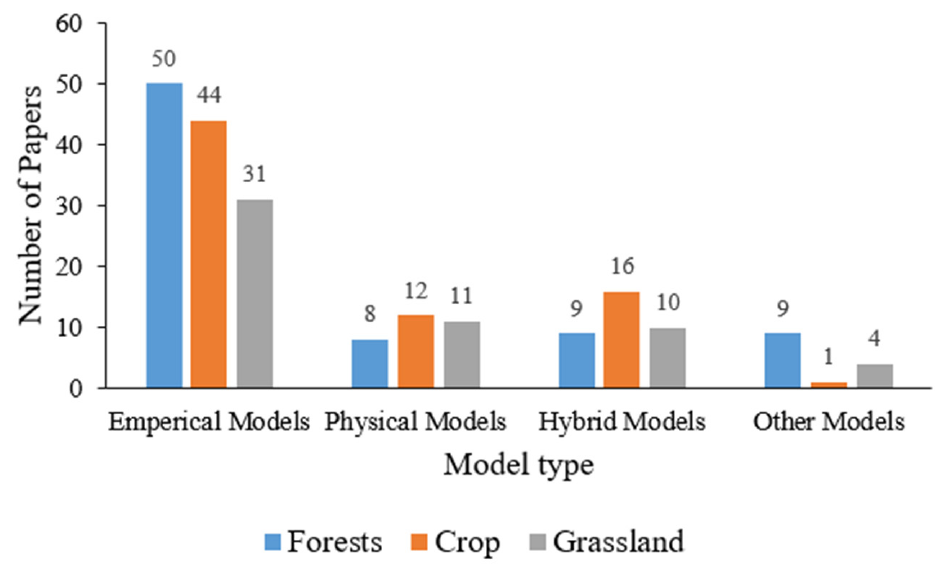
Figure 7. Distribution of different model types for forest, crop and grassland LAI estimations. This review showed that empirical models were the most often used models for estimating the LAI of forest environment from 2010 to 2020. In terms of physical and hybrid models, forests had the lowest number of studies compared to crops and grasslands. The differences may be attributed to the typically complex forest structures. The number of crop studies that used physical and hybrid models, particularly PROSIAL, was higher compared to forests and grasslands. In terms of model types, vegetation index-based models and reflectance models were the most often applied model types for forests, crops and grasslands. Table 2 illustrates the models and sensors used for forest, crop and grassland studies and the level of accuracy achieved by each model and Table 3 shows the number of studies that applied each type of model. The number of applied models was higher than the number of studies reviewed because 19 papers used more than one model. Table 2. Models and sensors used for forest, crop and grassland studies and the level of accuracy achieved by each model. Forest Crop